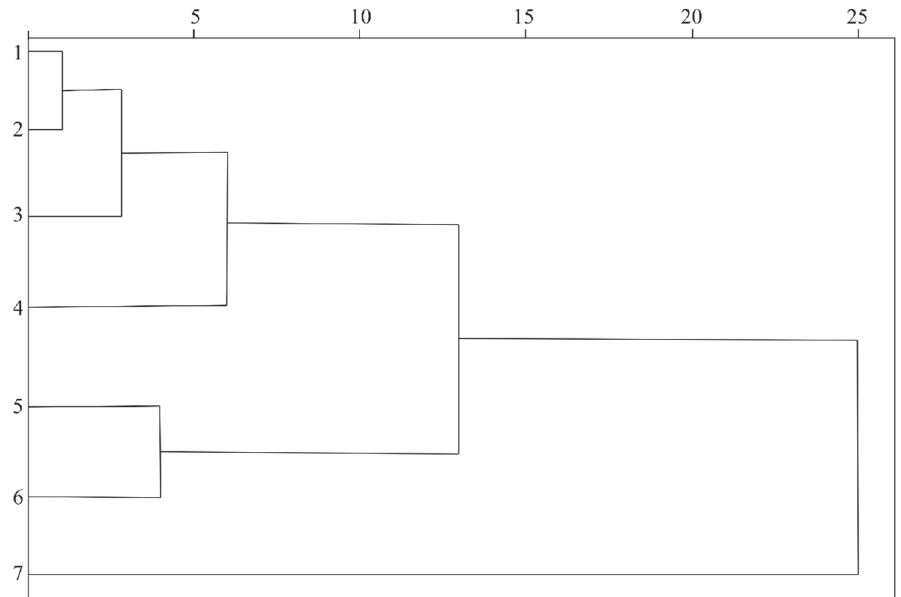
Figure 14. Results of hierarchical cluster analysis based on the occurrence of numerals in the texts by Ilf and Petrov. The horizontal scale indicates the “distance” between clusters in conventional units. Texts Nos. 1–7, combined into clusters, are indicated in the text of the paper.